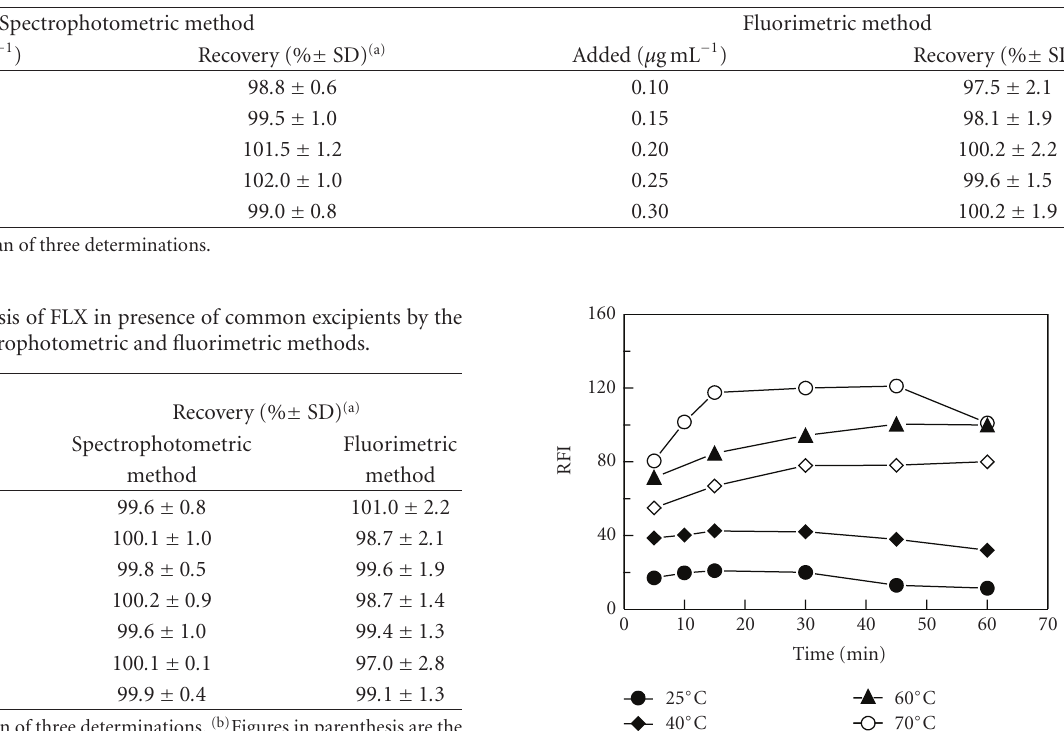
Table 4: Recovery studies for determination of FLX by the proposed spectrophotometric and fluorimetric methods.